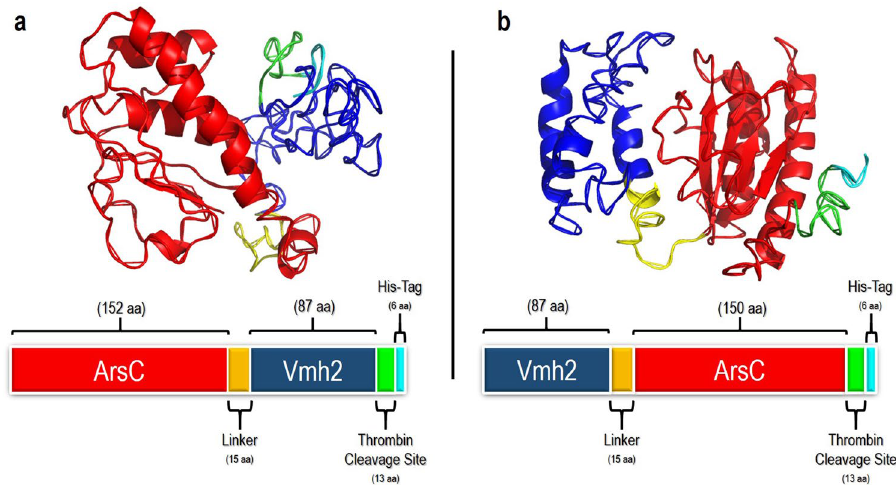
Figure 1. 3D models and schematic organization of the chimeric proteins. ( a ) ArsC-Vmh2 and ( b ) Vmh2- ArsC. In both panels ArsC is reported in red; Vmh2 in blue; the linker in yellow, the thrombin cleavage site in green and the His-tag in ciano.